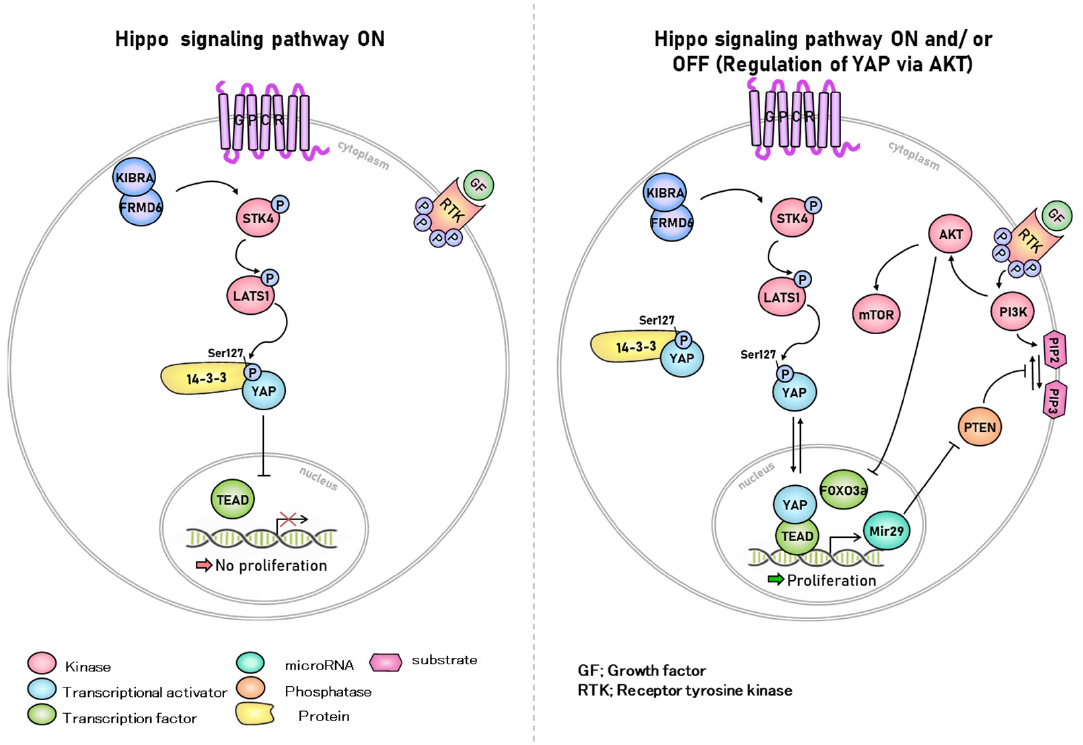
Figure 1. Hippo signaling pathway. YAP, a downstream target of the Hippo signaling pathway, activates the mammalian target of rapamycin (mTOR), a major regulator of cell growth. This sug- gests that the Hippo pathway, PTEN, and AKT are related. The stimulation of AKT and inhibition of the Hippo signaling pathway affect ovarian follicle growth. AKT activates dormant primordial follicles and promotes follicle growth by interfering with the Hippo signaling pathway by ovarian fragments. YAP regulates carcinogenesis in endometrial adenocarcinoma, and YAP expression cor- related with the type of endometrial adenocarcinoma. In addition, the Hippo signaling pathway is a key downstream signaling branch of the G protein-coupled estrogen receptor (GPER) and plays a crucial role in breast tumorigenesis.